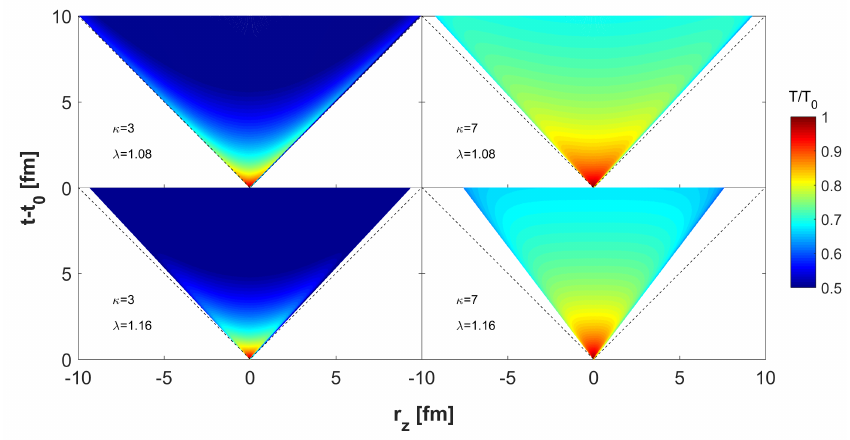
Figure 1. Temperature maps in the forward light cone from our new, longitudinally finite solutions for κ = ε / p = 3 (left column) and for κ = 7 (right column) evaluated for the acceleration parameters λ = 1.08 (top row) corresponding to a broader rapidity distribution and for λ = 1.16 (bottom row) corresponding to a narrower rapidity distribution, approximately corresponding to heavy ion collisions